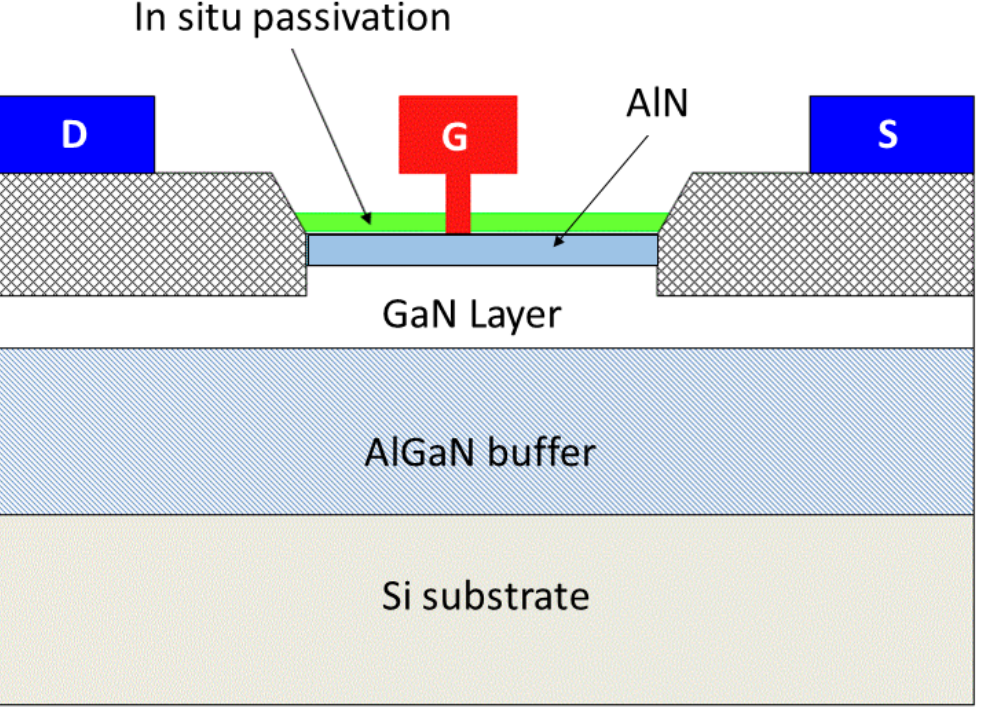
Figure 1. D01GH device’s cross